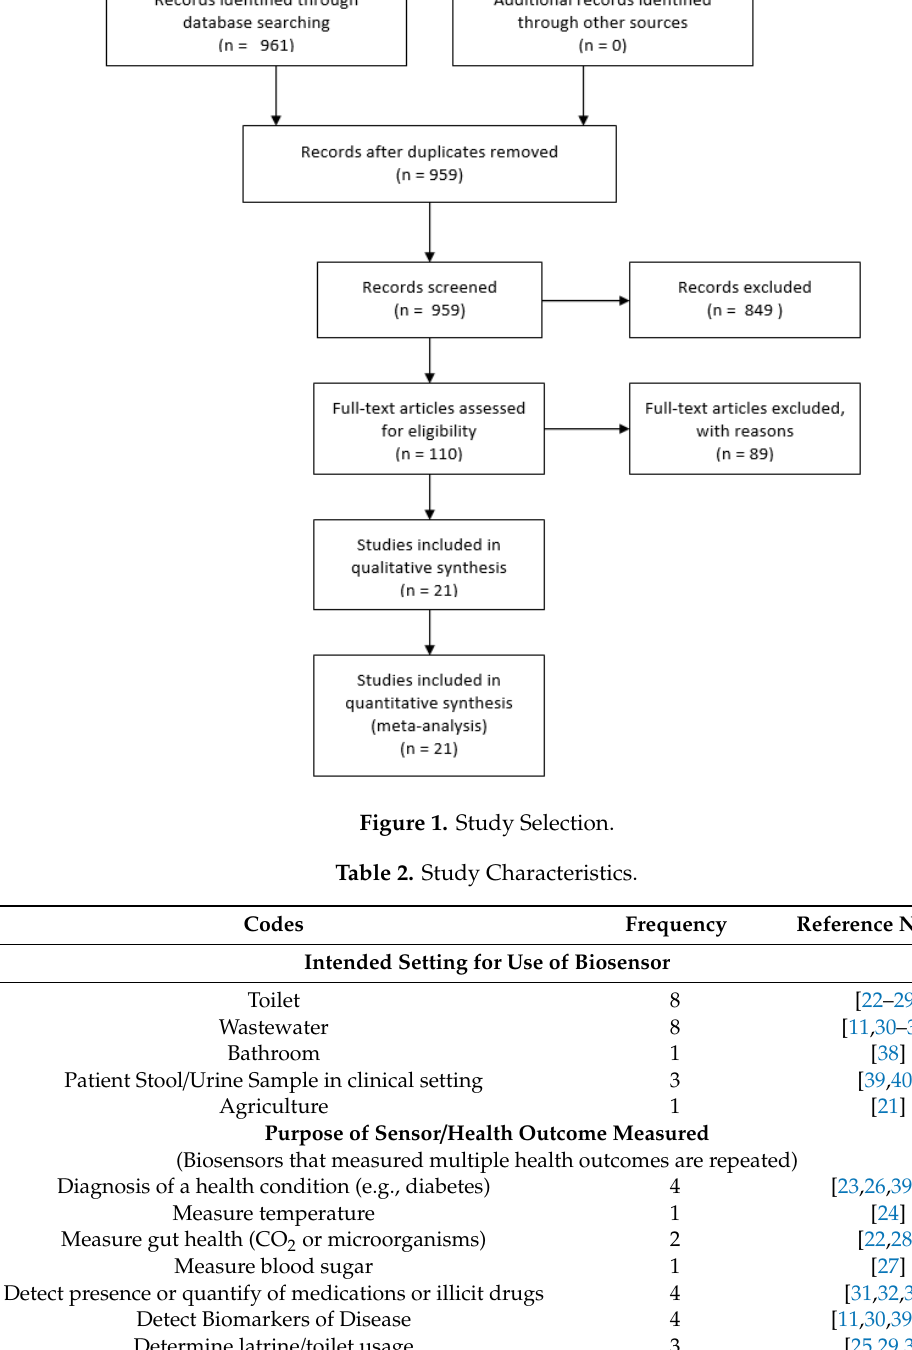
Table 2. Study Characteristics.